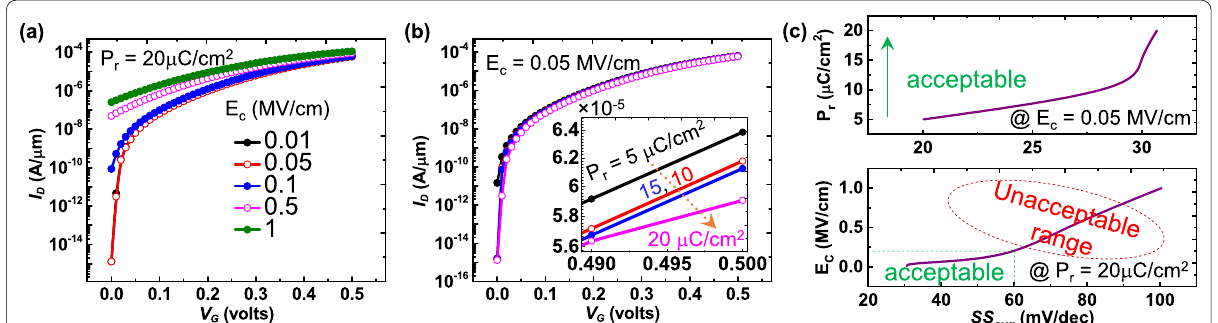
Fig. 6 FATFET performance under fixed a P r = 20 μC/cm 2 and b E c = 0.05 MV/cm. A high impact on gate leakage and tunneling through a high E c , resulting in high I off and I on . c The significance and appropriate choice of P r and E c estimation from the perspective of SS avg . Similar to plot ( a ), SS avg deteriorates at high E c , whereas P r is